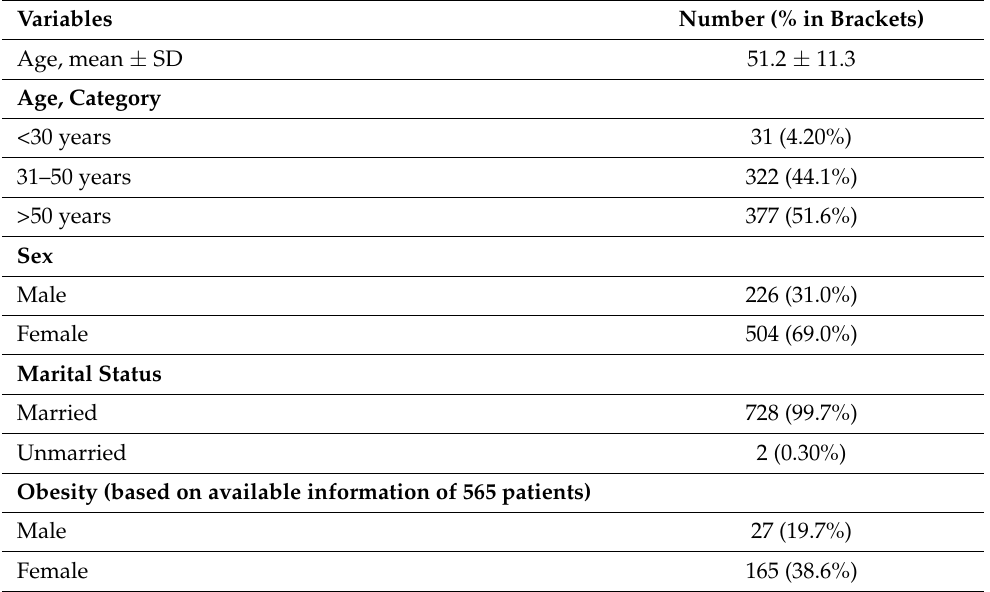
Table 1. Demographic characteristics of the